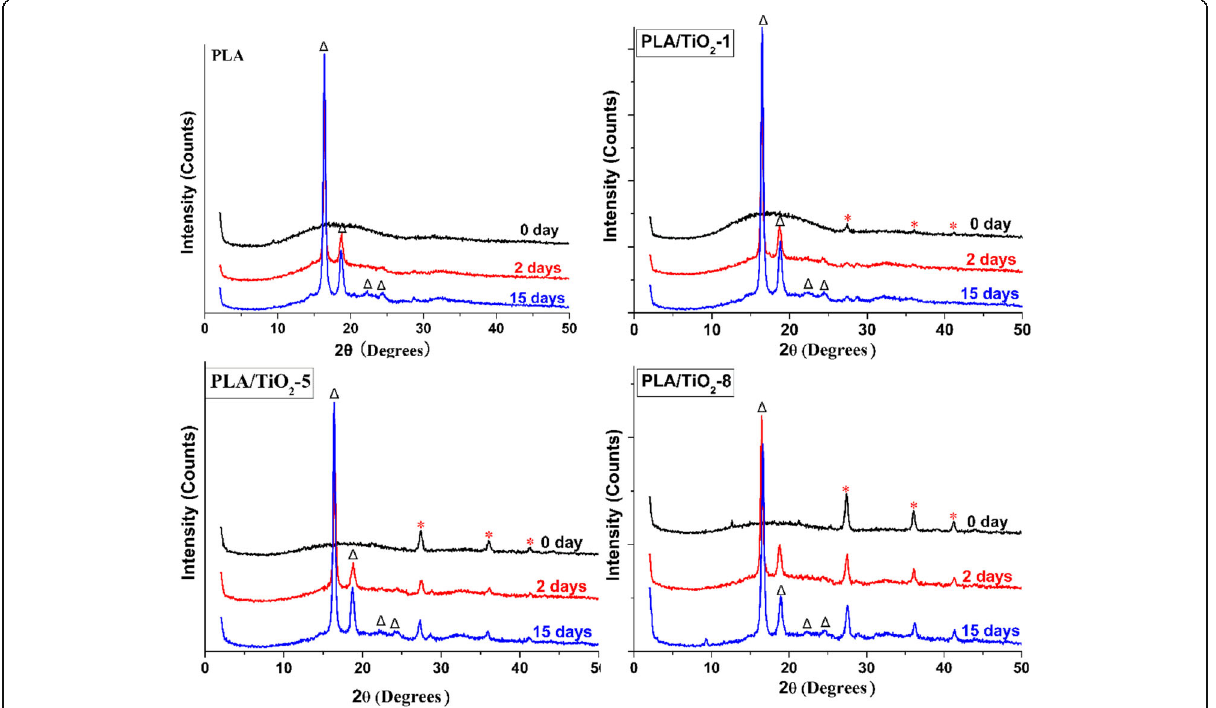
Fig. 4 XRD patterns of pure PLA and PLA/TiO 2 nanocomposites at different incubation times